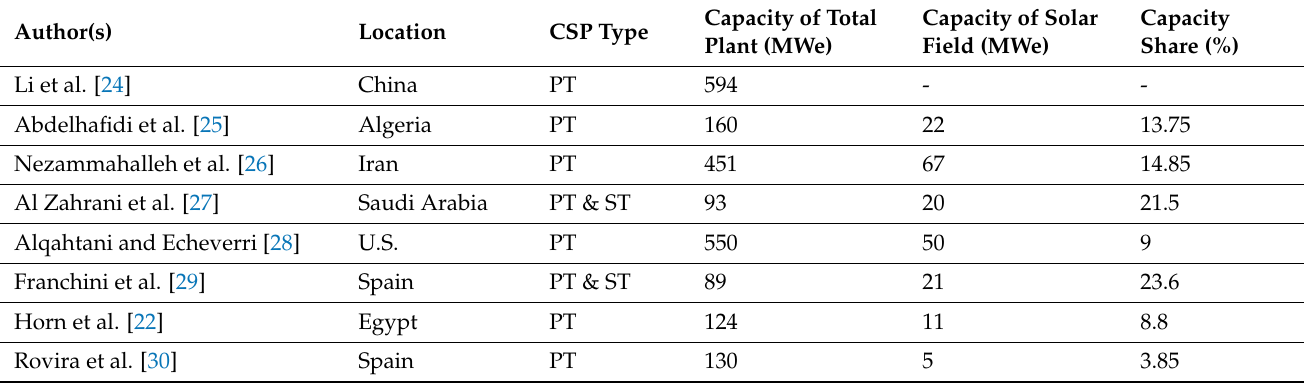
Table 1. Specifications for ISCC plants in previous